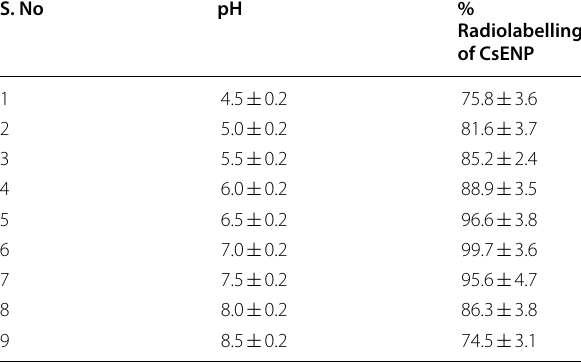
Table 1 Physicochemical Parameters of Optimized CsENP [18] Formulation code